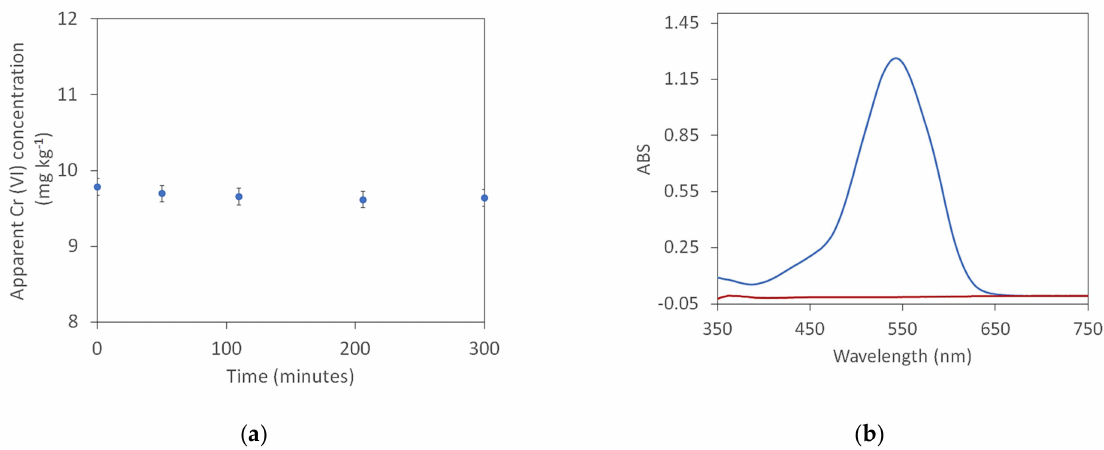
Figure 3. ( a ) Apparent Cr(VI) concentration (mg kg − 1 ) of a Cr(VI) and gelatine solution vs. extrac- tion time (minutes), ( b ) UV spectra of the same solution after 115 min: with DPC (Blue), without DPC